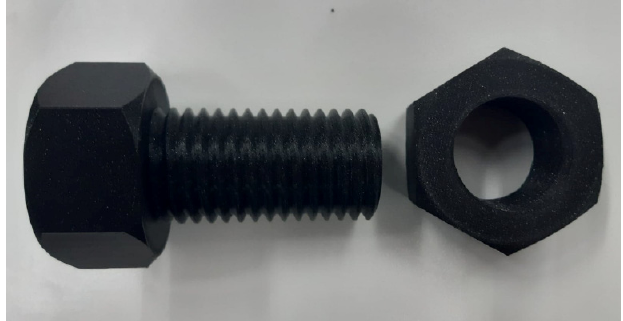
Figure 11. Parts printed with ABS + 2% Graphite filament.